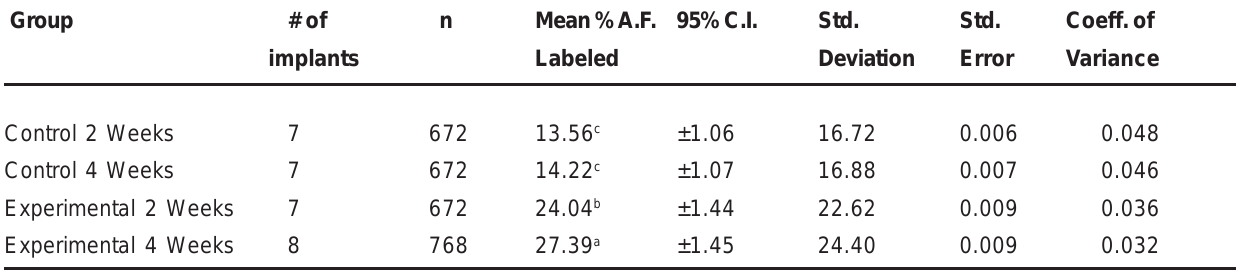
a,b, and c- statistical group CI overlap at 95% level of